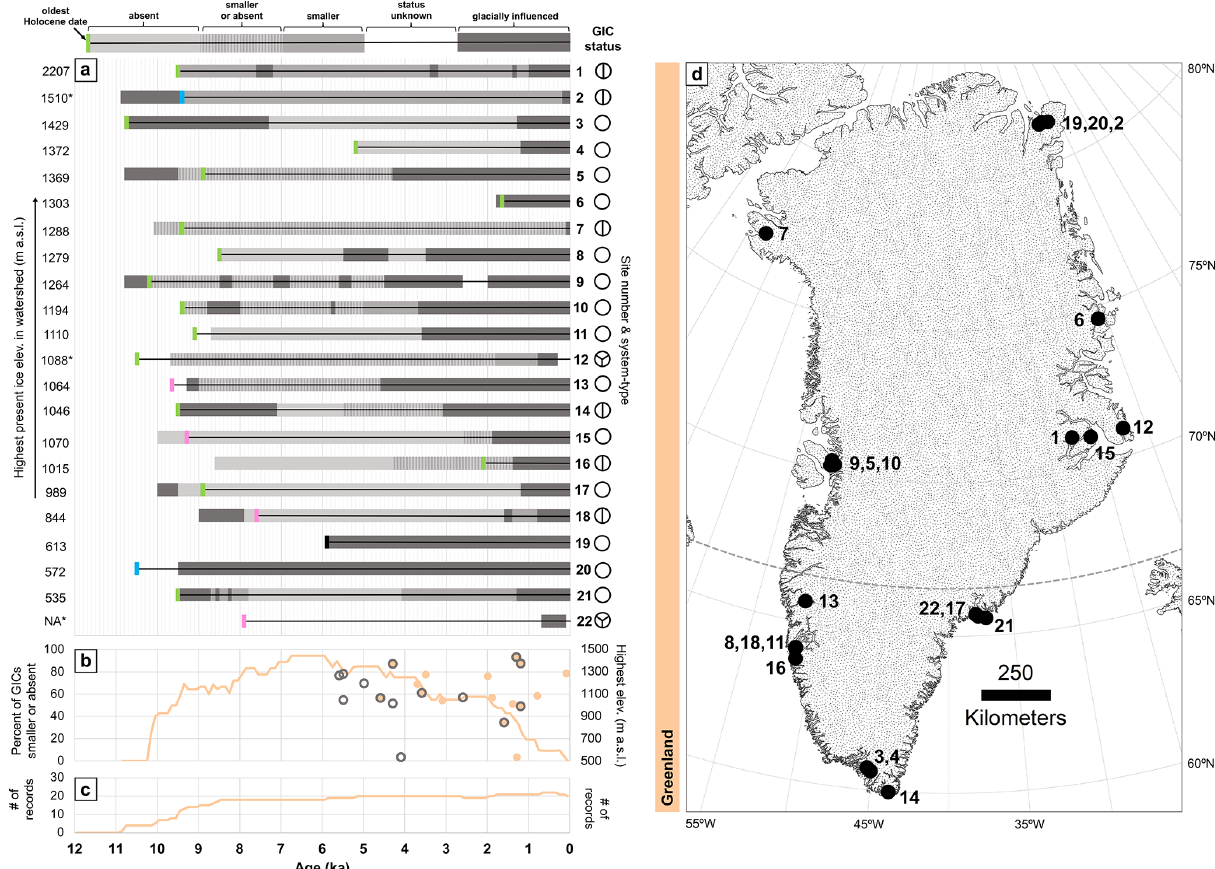
Figure 5. Holocene lake-based GIC records from Greenland. Panel descriptions, symbols, and colors are the same as in Fig. 3. Sites are as follows: 1. Medford et al. (2021) (Rapids and Bunny lakes, Renland Ice Cap); 2. Larsen et al. (2019) (Lake T3 and T8, Flade Isblink Ice Cap); 3. Larocca et al. (2020a) (Alakariqssoq Lake, unnamed glaciers); 4. Larocca et al. (2020a) (Uunartoq Lake, unnamed glaciers); 5. Schweinsberg et al. (2019) (Pauiaivik Lake, Sermikassak Glacier); 6. Adamson et al. (2019) (Madsen Lake, Slettebreen Ice Cap); 7. Axford et al. (2019) (Deltasø Lake, North Ice Cap); 8. Larsen et al. (2017) (Badesø Lake, RGI40–05.07196 and RGI40–05.07208 glaciers); 9. Schweinsberg et al. (2019) (Saqqap Tasersua Lake, Qangattaq Ice Cap); 10. Schweinsberg et al. (2017) (Sikuiui Lake, Qangattaq Ice Cap); 11. Larsen et al. (2017) (Langesø Lake, RGI40–05.07196 glacier); 12. Lowell et al. (2013) (Bone Lake, Istorvet Ice Cap); 13. Schweinsberg